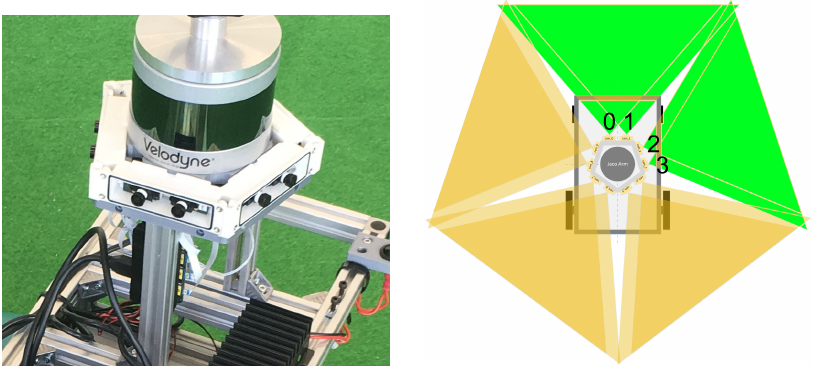
Figure A2. Pentagonal camera rig mounted on the robot (left). The first four cameras were included in the challenge data (right), green colour indicates their fields of view.